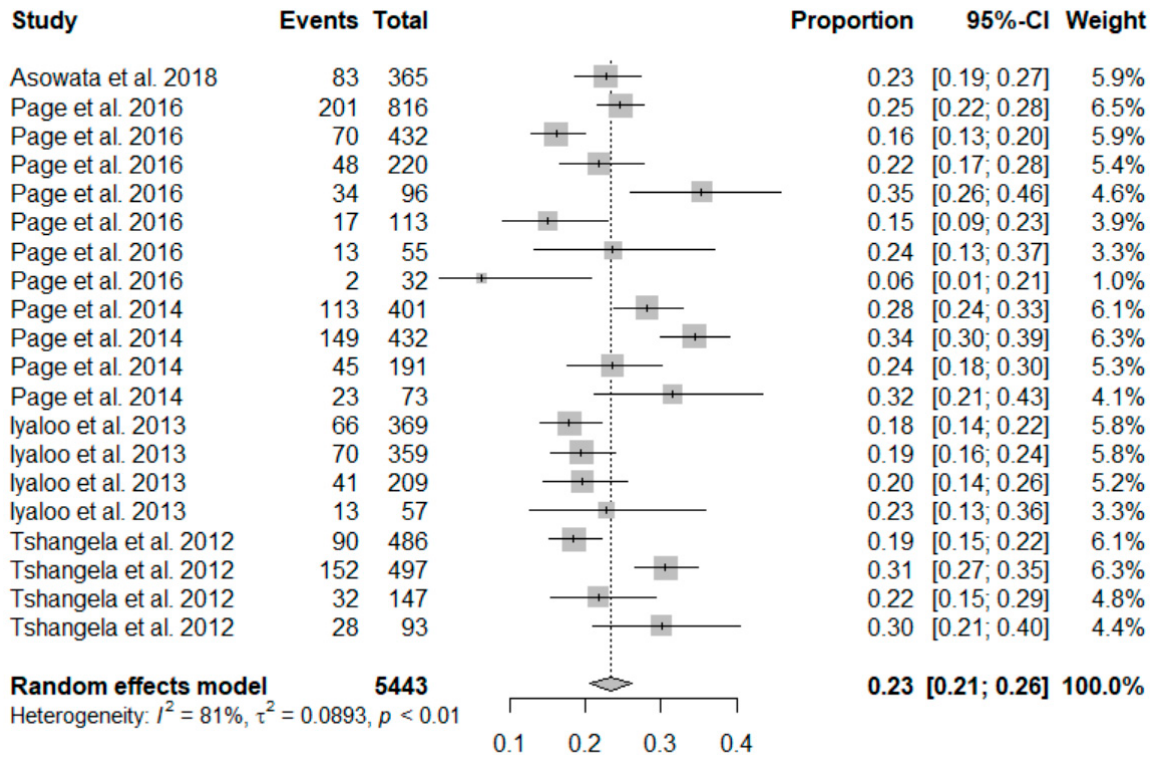
Figure 3. Forest plot showing the pooled prevalence of rotavirus cases after the inclusion of rotavirus vaccination in South Africa.